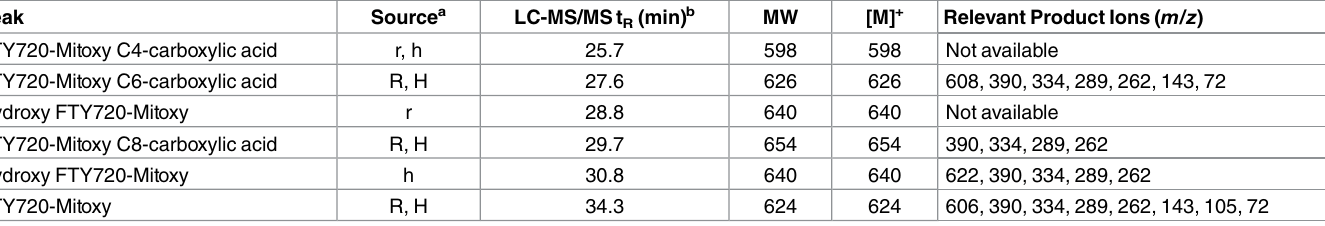
proposed fragmentation scheme and products of [M+H] + of FTY720-C2 are shown in Fig 2A. Neutral losses of water and the N -acetyl group generated product ions at m/z 332, 314, and 255, respectively (Fig 2A, blue text on the fragmentation scheme and mass spectrum).An unchanged N -acetyl moiety was indicated for FTY720-C2 and its metabolites by the product ion at m/z 60. Fragmentation of the octyl and ethylpropyl aliphatic chains generated the major- ity of the remaining observedproduct ions. The mass spectrum ion intensity and proposed fragmentation schemes of FTY720-C2 metabolites: hydroxy FTY720-C2, FTY720-C2 C8-car- boxylic acid, FTY720-C2 C4 carboxylic acid, and FTY720-C2 C2-carboxylic acid are shown in Fig 2B–2E. For each FTY720-C2 metabolite, mass spectral data indicated the acetylamino moi- ety, phenyl ring and aliphatic carbon atoms closest to the phenyl ring as being unchanged. Pro- tonated FTY720-C2 C8-, C4-, and C2-carboxylic acid metabolites generated no butyl or pentyl product ions at m/z 71 or 57, respectively, suggesting metabolism of the octyl side chain. Also, protonated FTY720-C2 C4- and C2-carboxylic acids metabolites generated fragments at m/z 177 and m/z 149, respectively, which indicated an elimination of a 2-carbon unit of the octyl side chain (Fig 2C and 2D, green text on the fragmentation schemes). Similarly, the m/z 243 product ion of FTY720-C2 shifting from m/z 273 to 217 and 189, for FTY720-C2 C8-, C4-, and C2-carboxylic acid metabolites, indicated a sequential and stepwise elimination of 2-carbon units (Fig 2C–2E, green text on the fragmentation schemes). In combination, the metabolites present in the chromatogram (Fig 1) were tentatively identified as FTY720-C2 C8-, C6-, C4- and C2-carboxylic acids. Hydroxylation of the octyl side chain including its benzyl carbon was proposed, partly based on the observation of the generation of multiple carboxylic acids from the octyl side chain. The fragment ion at m/z 243 of FTY720-C2 was shifted to m/z 259 (Fig 2B, red text on the fragmentation scheme), which correlated with a hydroxyl group replacing a Table 5. Summaryof the structural characterizationby LC-MS/MSof FTY720-Mitoxy MetabolitesIdentifiedin Rat and HumanHepatocytes.